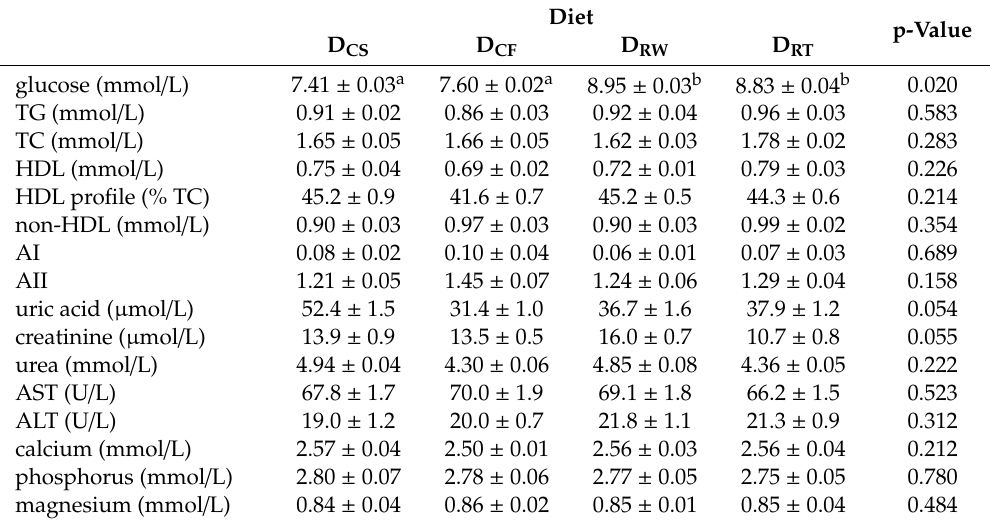
Table 8. Selected biochemical characteristics of rats’ blood serum. Data are expressed as mean ± SEM, n =